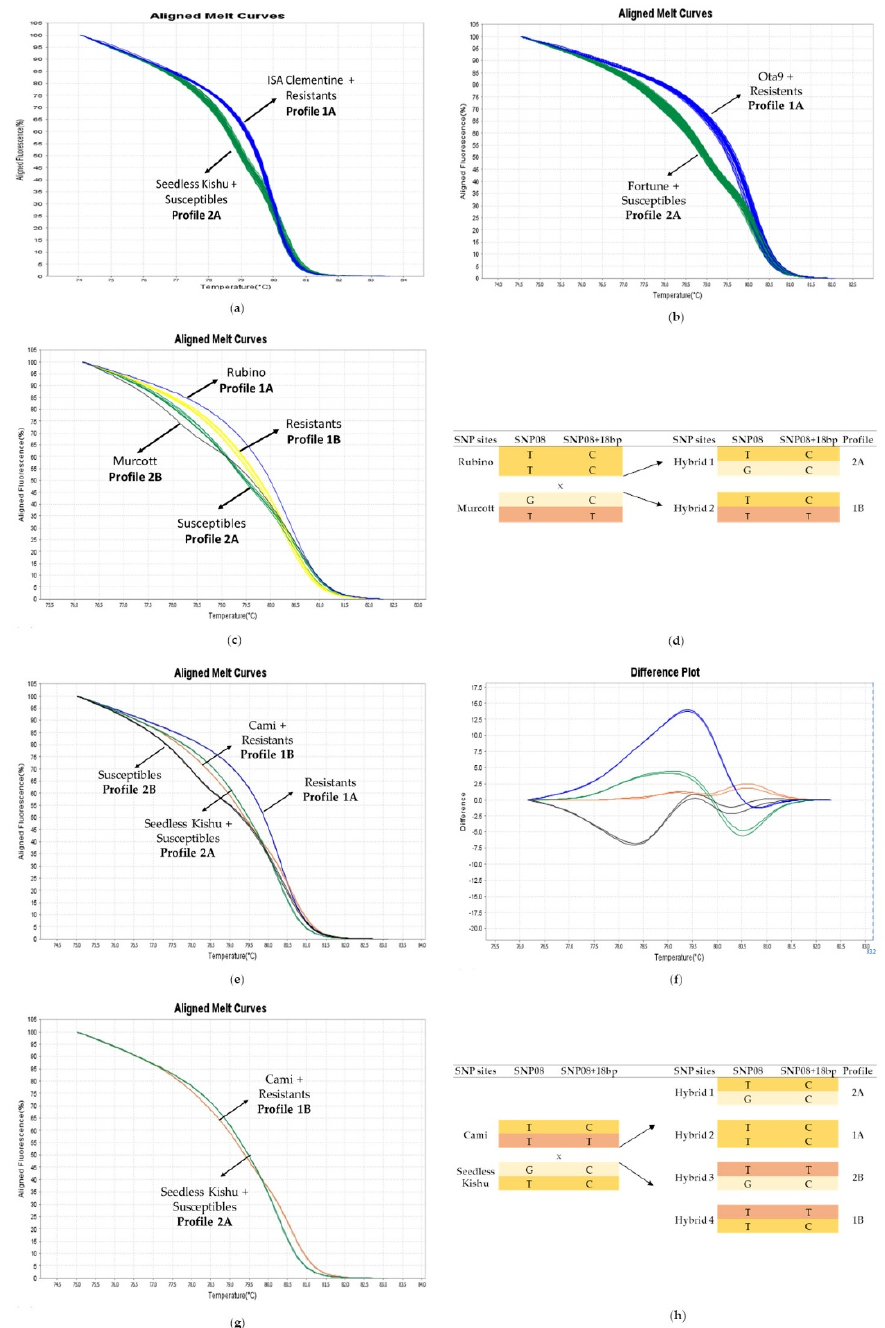
Figure 5. Aligned melt curves of resistant and susceptible mandarin hybrids. ( a ) ISA × Seedless Kishu; ( b ) Fortune × Ota9; ( c ) Rubino, Murcott and their hybrids; ( d ) segregation scheme of the Rubino × Murcott population based on the HRM genotyping and Sanger sequencing results; ( e ) Cami × Seedless Kishu melt curves, showing four different profiles in the progenies; ( f ) Cami × Seedless Kishu difference plot, facilitating the interpretation of the genotyping results; ( g ) melt curves of 1B and 2A hybrids of the Cami × Seedless Kishu population, showing slightly different profiles; ( h ) segregation scheme of Cami × Seedless Kishu based on the HRM genotyping and Sanger sequencing results.